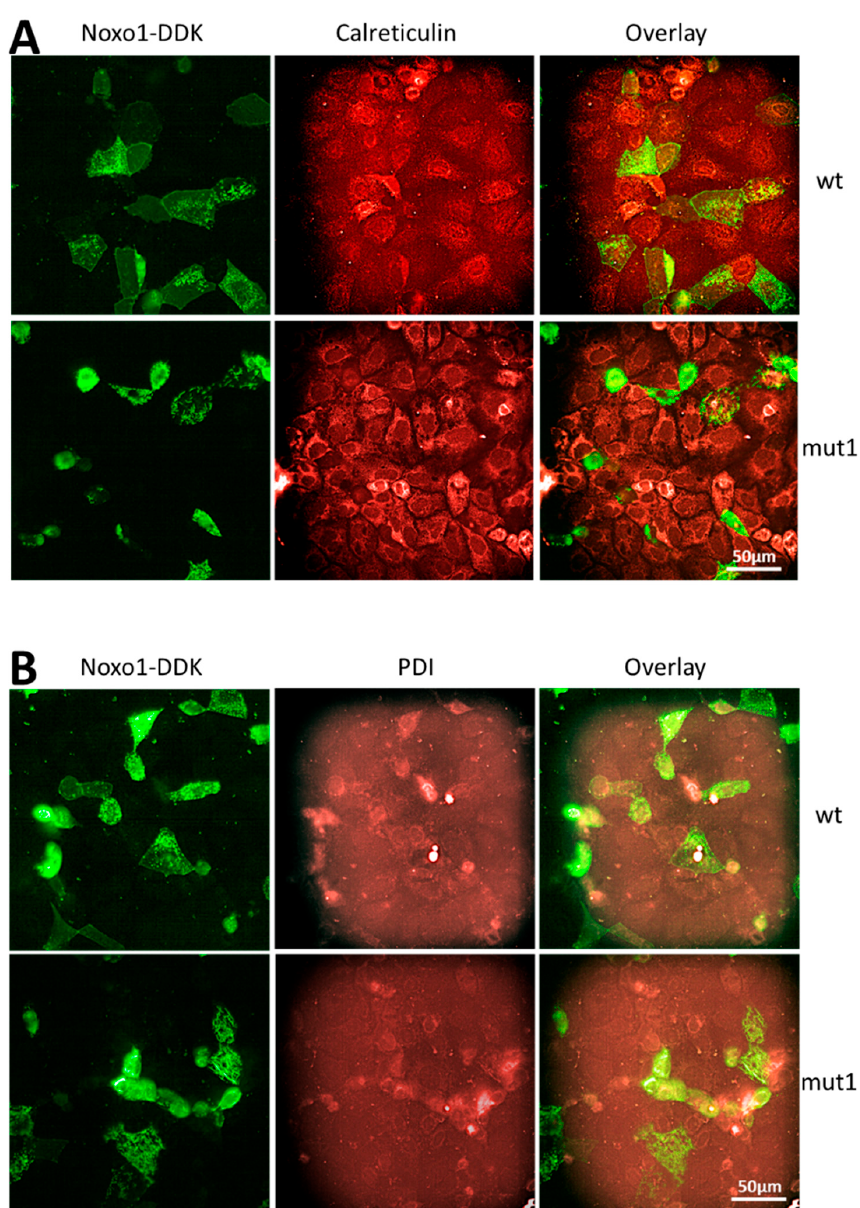
Figure A1. Image projections from High Content Screening (HCS) showing immunofluorescence Noxo1 with calreticulin or PDI, markers of endoplasmic reticulum in Caco-2 transfected with wt Noxo1- or mut1 Noxo1-DDK. ( A ) Immunofluorescence wt Noxo1-DDK (left upper panel, green) and calreticulin (middle upper panel, red). The overlay upper right panel corresponds to wt Noxo1- DDK/calreticulin. Immunofluorescence mut1 Noxo1-DDK (left lower panel, green) and calreti- culin (middle lower panel, red). The overlay (right upper panel) corresponds to mut1 Noxo1- DDK/calreticulin. ( B ) Immunofluorescence wt Noxo1-DDK (left upper panel, green) and PDI (middle upper panel, red). The overlay upper right panel corresponds to wt Noxo1-DDK/PDI. Immunofluo- rescence mut1 Noxo1-DDK (left lower panel, green) and PDI (middle lower panel, red). The overlay (right upper panel) corresponds to mut1 Noxo1-DDK/PDI. There is no clear colocalization of Noxo1 with calreticulin or PDI for either the wt or mut1 form of Noxo1 since most of the cells that dis- play high noxo1 staining are lightly stained for calreticulin or PDI, suggesting that Noxo1 is not sequestrated in the ER. Scale bars: 50 µ M in all